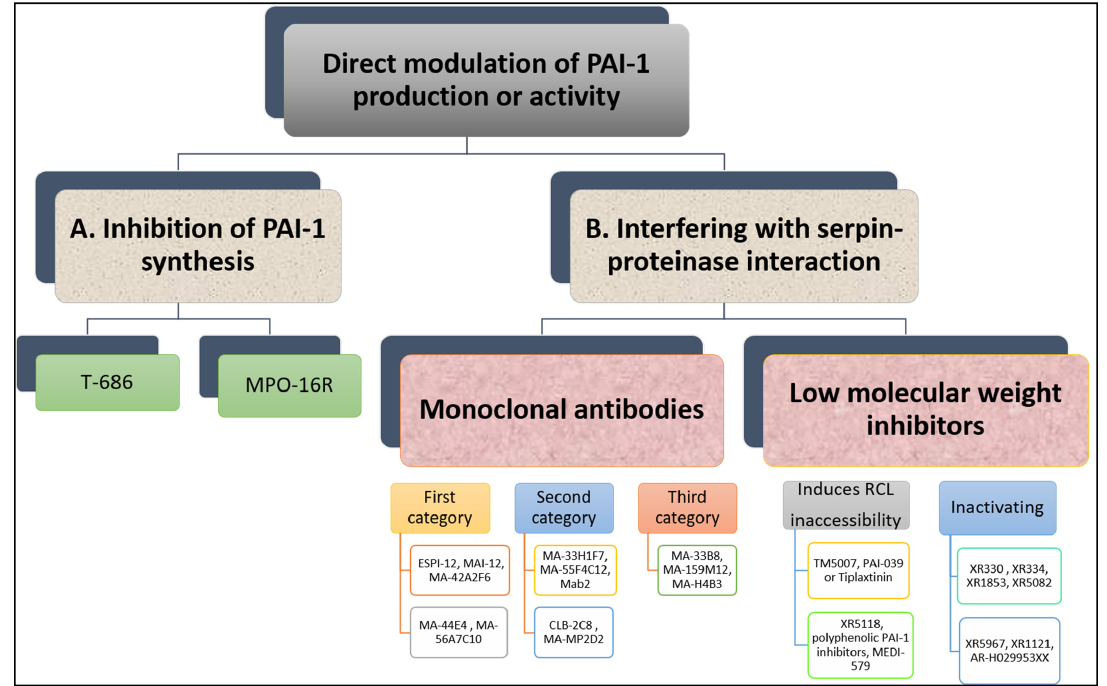
Figure 5. Overview of direct modulation of PAI-1 production or activity by (A) inhibition of PAI-1 synthesis or (B) interfering with serpin–proteinase interaction.